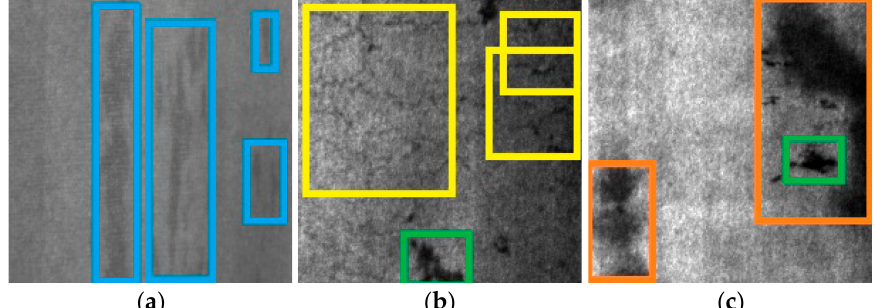
Figure 1. Complex defects on the steel strip surface, boxes of the same color represent the same defect type. ( a ) multiple defects; ( b ) multiclass defects; ( c ) overlapping defects.